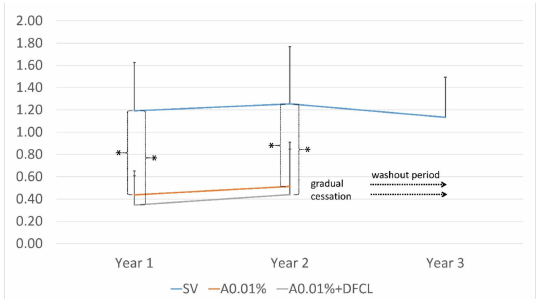
Figure 1. Increase in myopia over three years in the group wearing single-vision spectacle lenses (SV), two years of treatment with 0.01% atropine (A0.01%), and two years wearing dual-focus contact lenses (DFCL) with A0.01% (A0.01% + DFCL). One asterisk (*) represents a significant p value ( p < 0.01). SV: single-vision spectacle lenses. A0.01: 0.01% atropine for two years of treatment. A0.01% + DFCL: contact lenses with dual focus and topical 0.01% atropine for two years. Half a year after the cessation of the atropine treatment, the myopia progression (rebound effect (was − 0.24 ± 0.35 D and − 0.18 ± 0.34 D in the A0.01% and A0.01% + DFCL